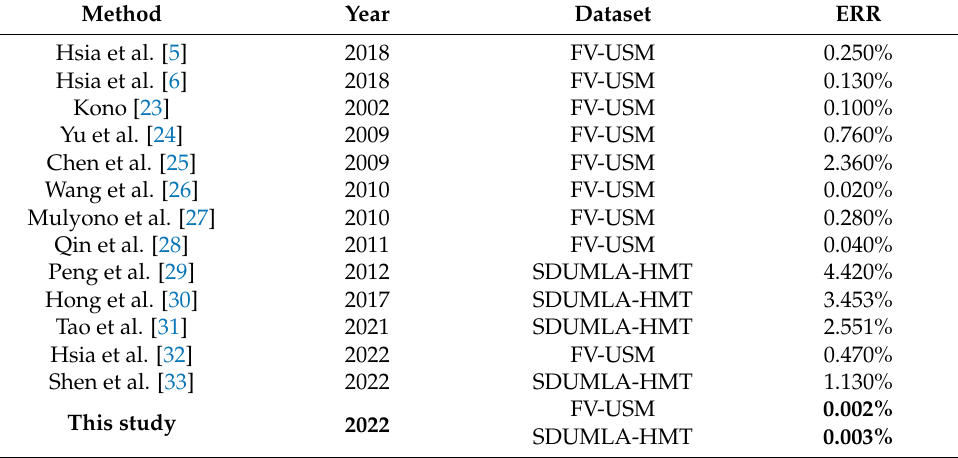
Table 3. Comparison with the results for other recent